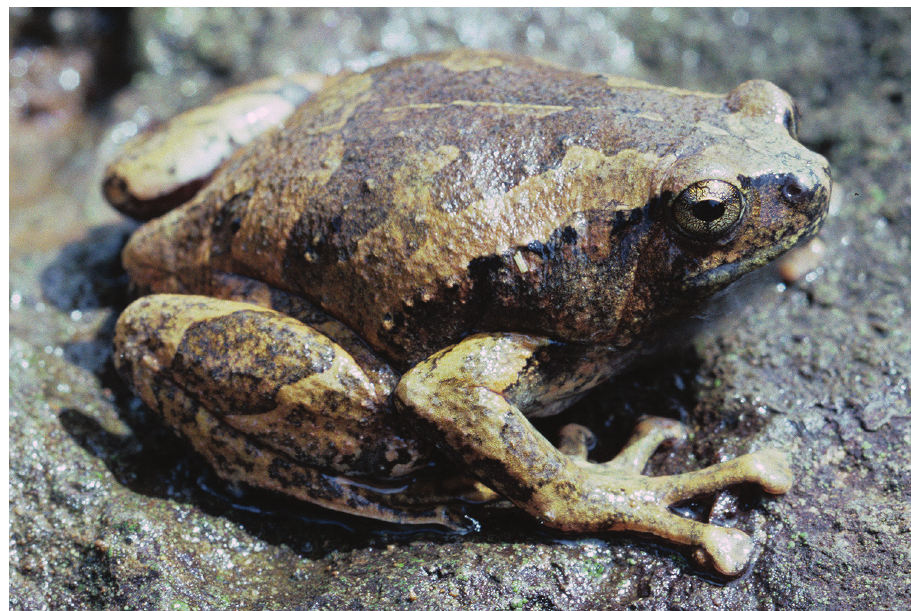
Figure 21. Kaloula conjuncta meridionalis females (KU 319452–53) were collected from Mt. Magdiwata, Barangay Bayugan II, Municipality of San Francisco, Agusan del Sur Province. Photo: RMB (TNHC 59636; from Municipality of Toril, Davao City